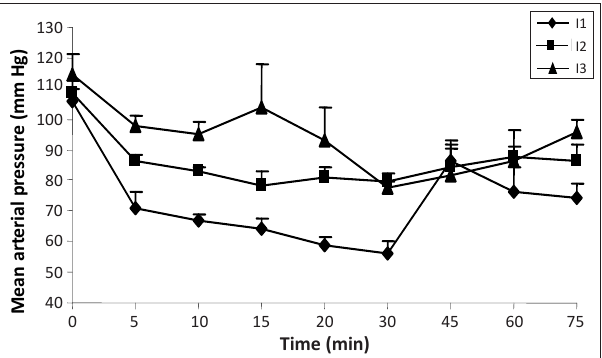
FIGURE 8: Mean ± standard error of mean arterial pressure (mm Hg) in water buffaloes of different groups.